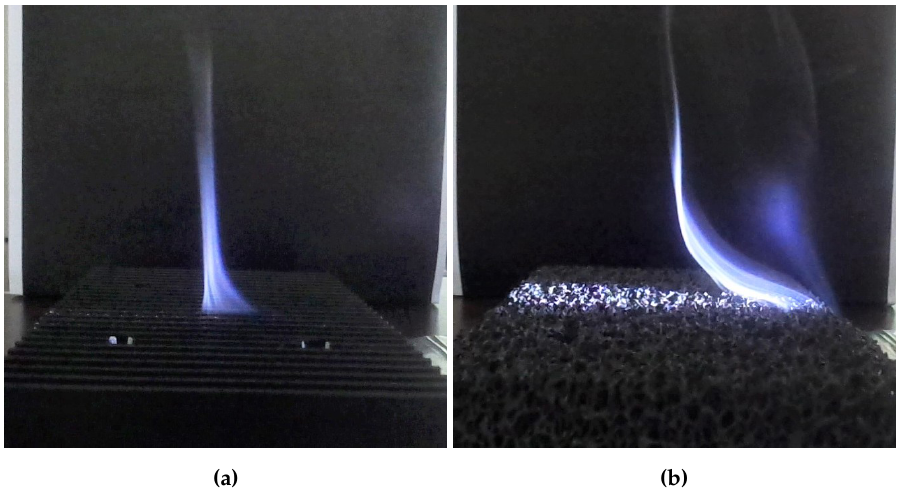
Figure 9. Visualization of the air flow through ( a ) the finned heat sink (Aavid R (cid:13) S120) and ( b ) the in-house-made aluminum foam heat sink (reticulated22) using smoke ( ∆ T = 70 ◦ C, horizontal